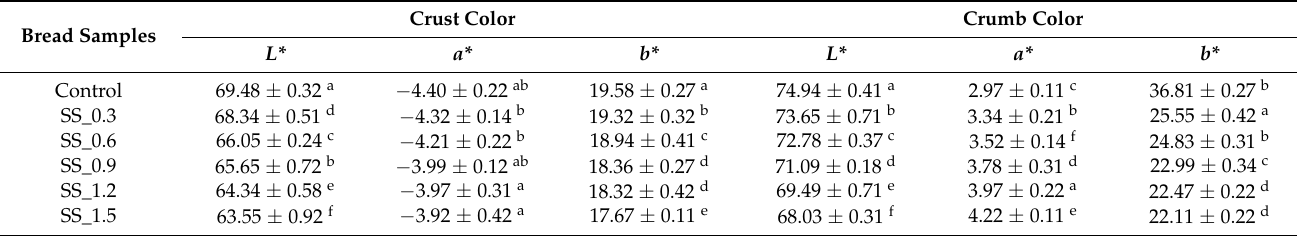
Table 6. Color parameters of the bread samples with different levels of sea salt with low sodium content (SS)